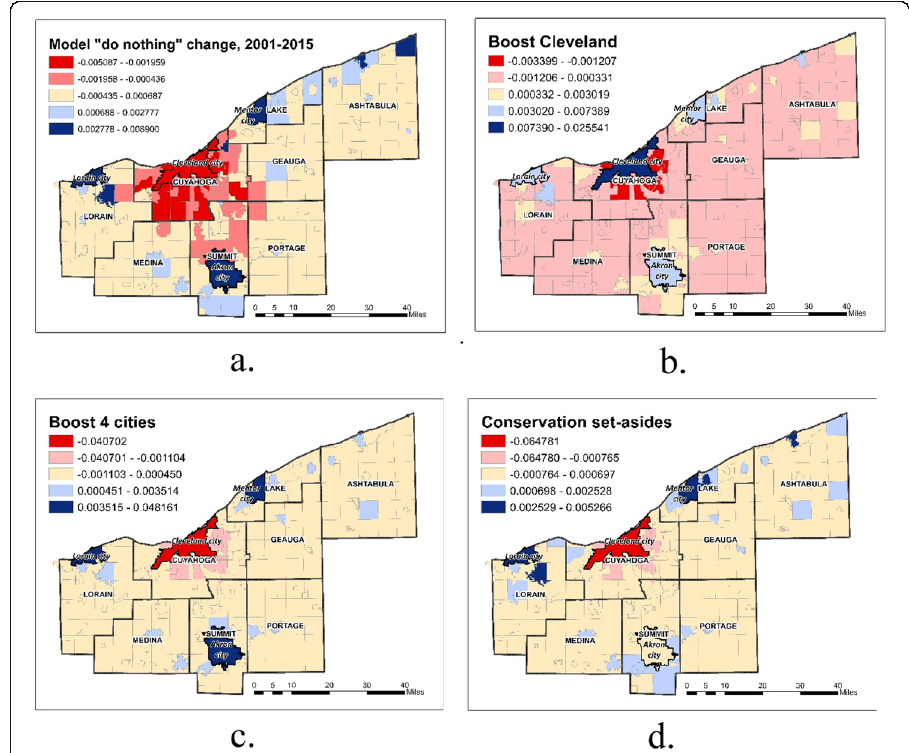
Fig. 8 Regional employment location — change from 2001 to 2015 in the “ do-nothing ” and in 3 anticipatory scenarios for the NEO region: a . “ do-nothing ” ; b . boost Cleveland in 4 consecutive time periods; c . boost 4 legacy cities (including Cleveland) in 4 consecutive time periods; d . conservation set-asides along the Cuyahoga National